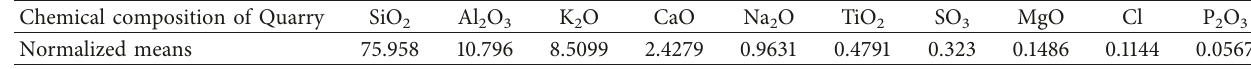
Table 1: % of chemical composition of recycled Quarry.